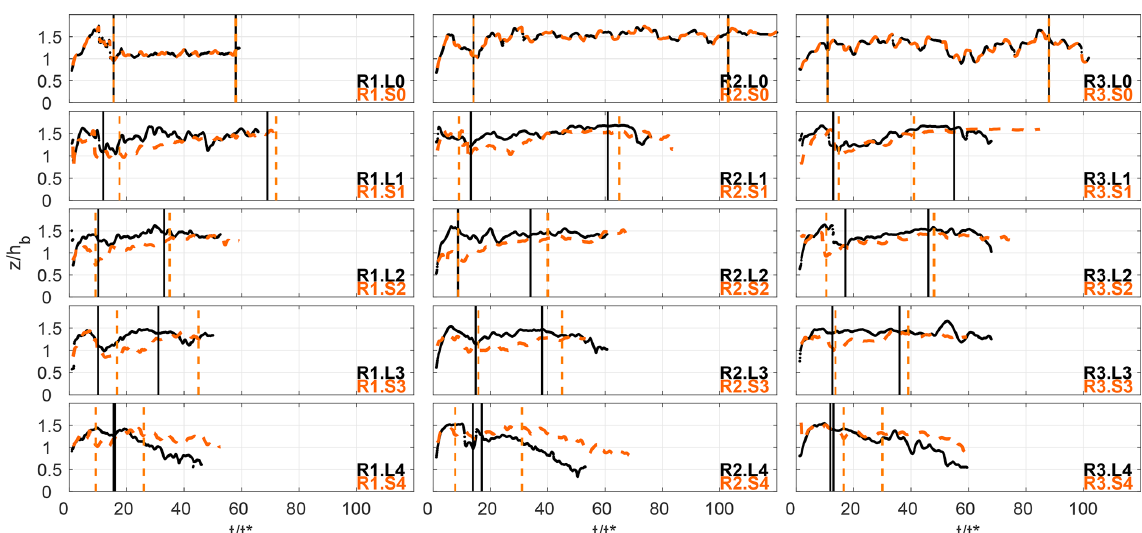
Figure 4. Gravity current contours, as identified by the zero streamwise velocity contour, for tests with the lock slope and correspondent tests with lock-length